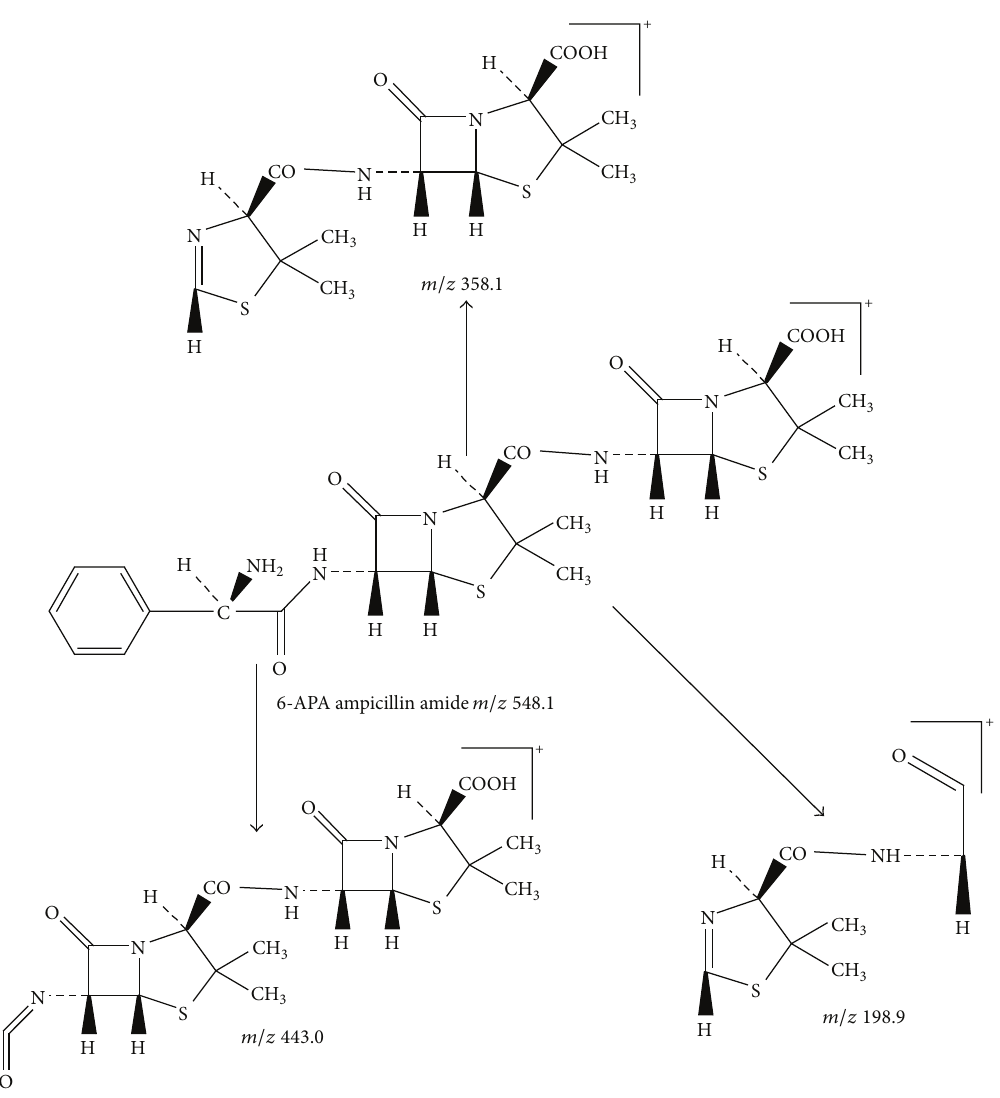
Figure 10: Proposed fragmentation pathway for the fragmentation ion of 6-APA ampicillin amide.